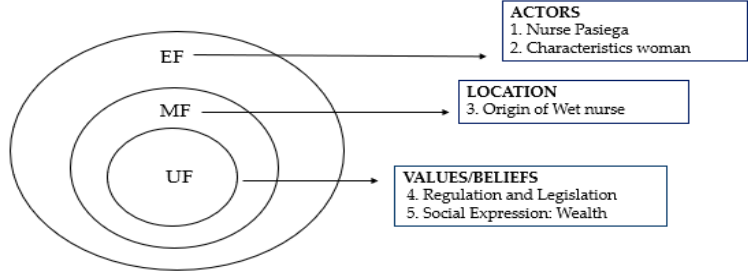
Figure 1. Theoretical dialectical structural model of care (DSMC) model: application of its structures. Source: authors’ own elaboration.